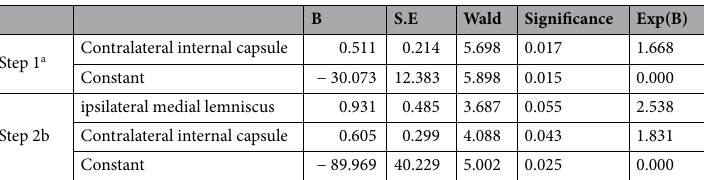
Table 3. Binary logistic regression of averaged diffusion metrics. B regression coefficient, S.E Standard Error, Exp ( B ) odds